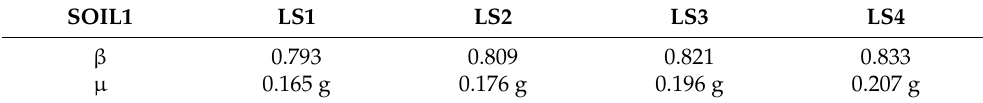
Figure 6. Comparison: SSI effects. Table 5. Lognormal standard deviation ( β ) and median ( µ ) values of SOIL1 at limit states (LSi). SOIL1